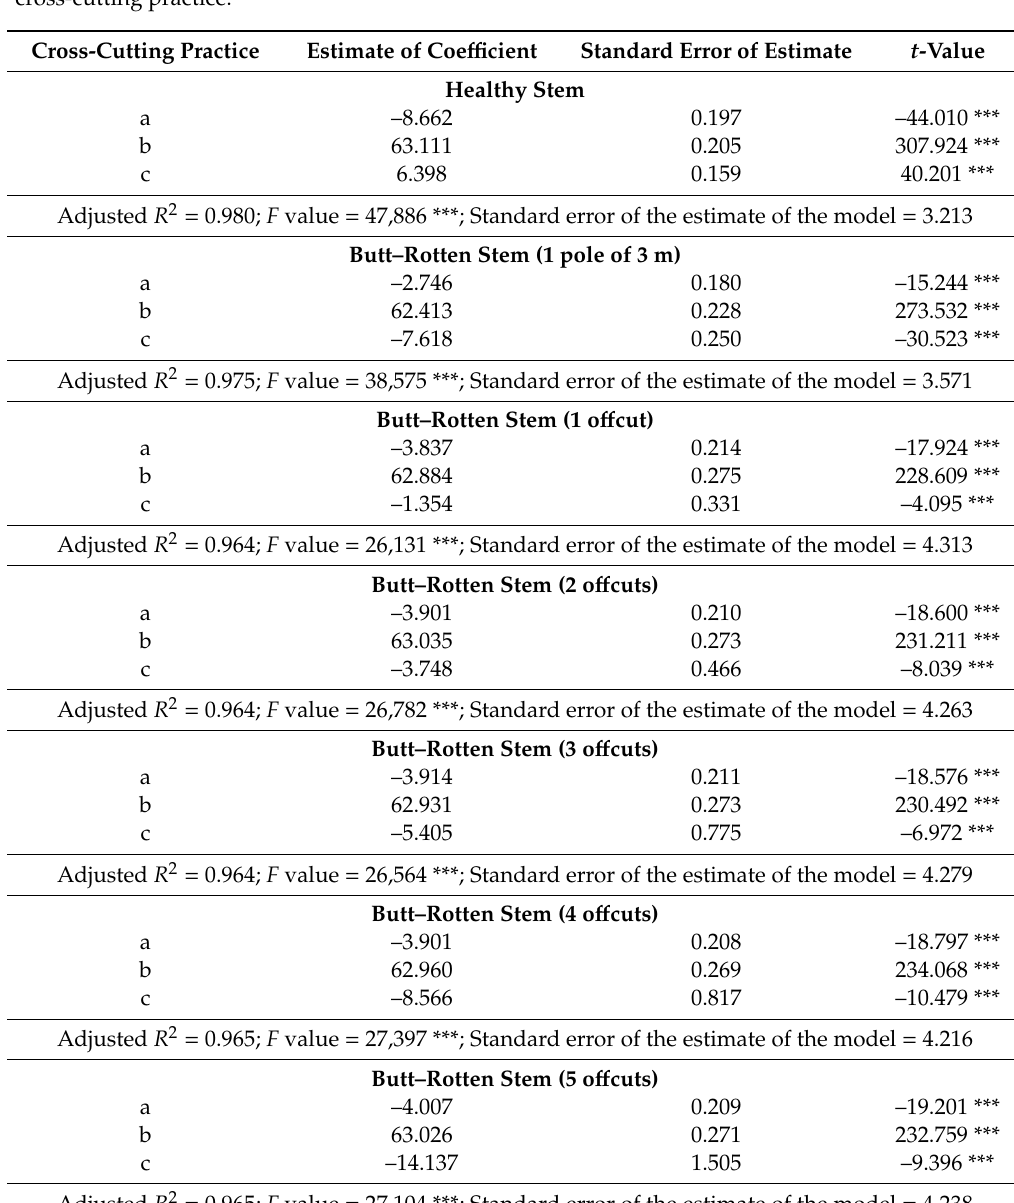
Regression models for the value recovery of the stem at the roadside landing by cross-cutting